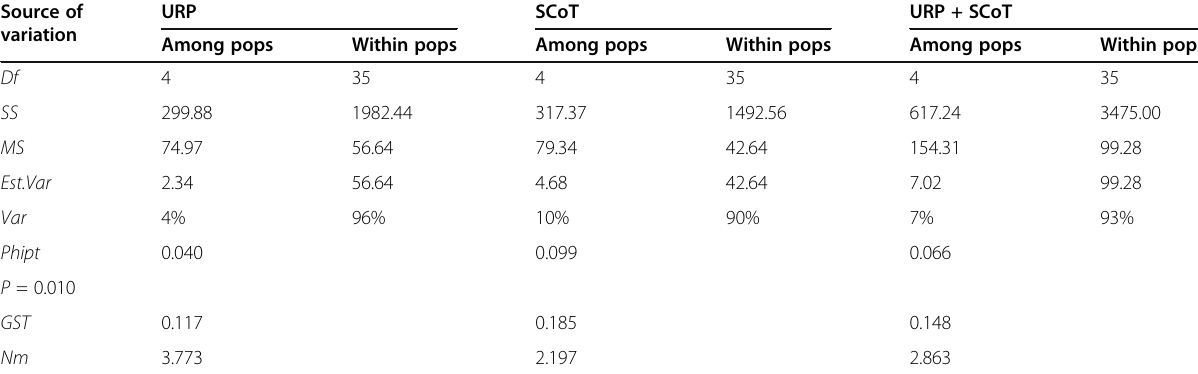
Table 3 Analysis of molecular variance (AMOVA) based on SCoT, URP, and combined data in Rosa damascena Mill. populations Source of